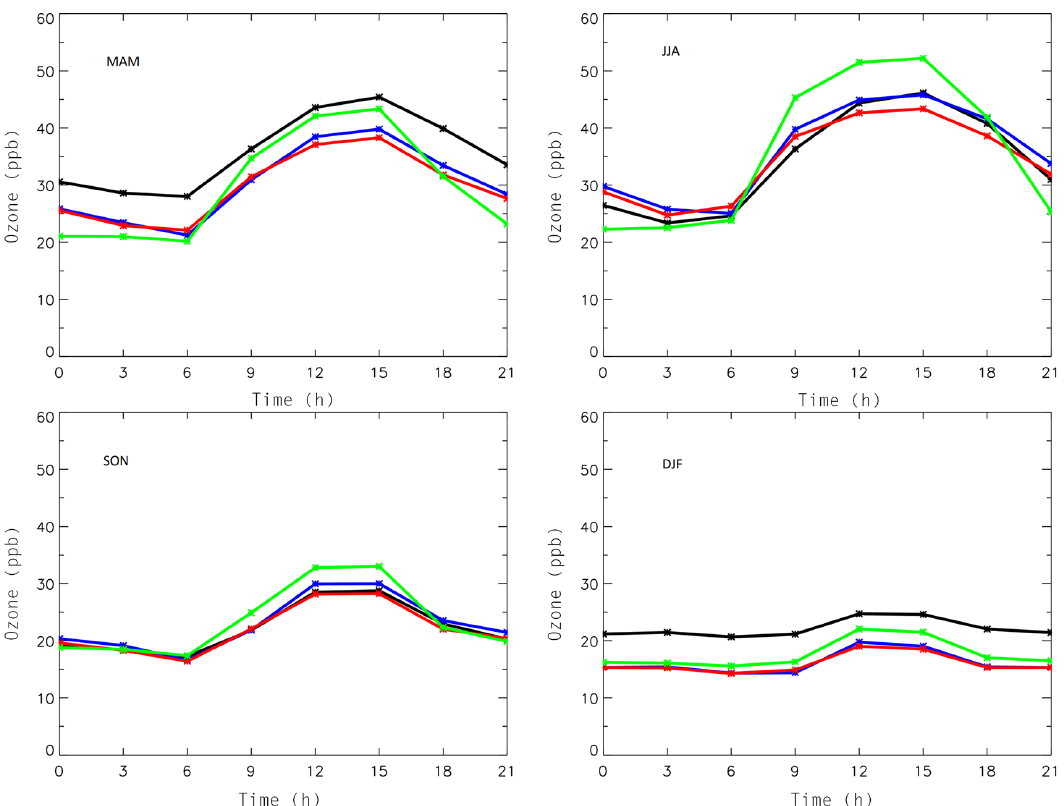
Figure 23. Average diurnal cycle of ozone at EMEP AirBase stations in Europe (black) for the seasons MAM (top left), JJA (top right), SON (bottom left), and DJF (bottom right) for CAMSiRA (red), the CR (blue), and MACCRA